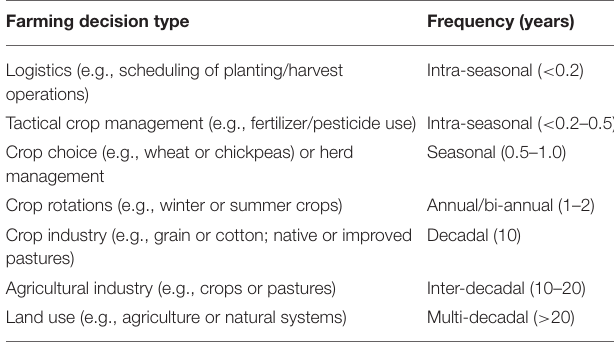
TABLE 1 | Agricultural decisions at a range of temporal